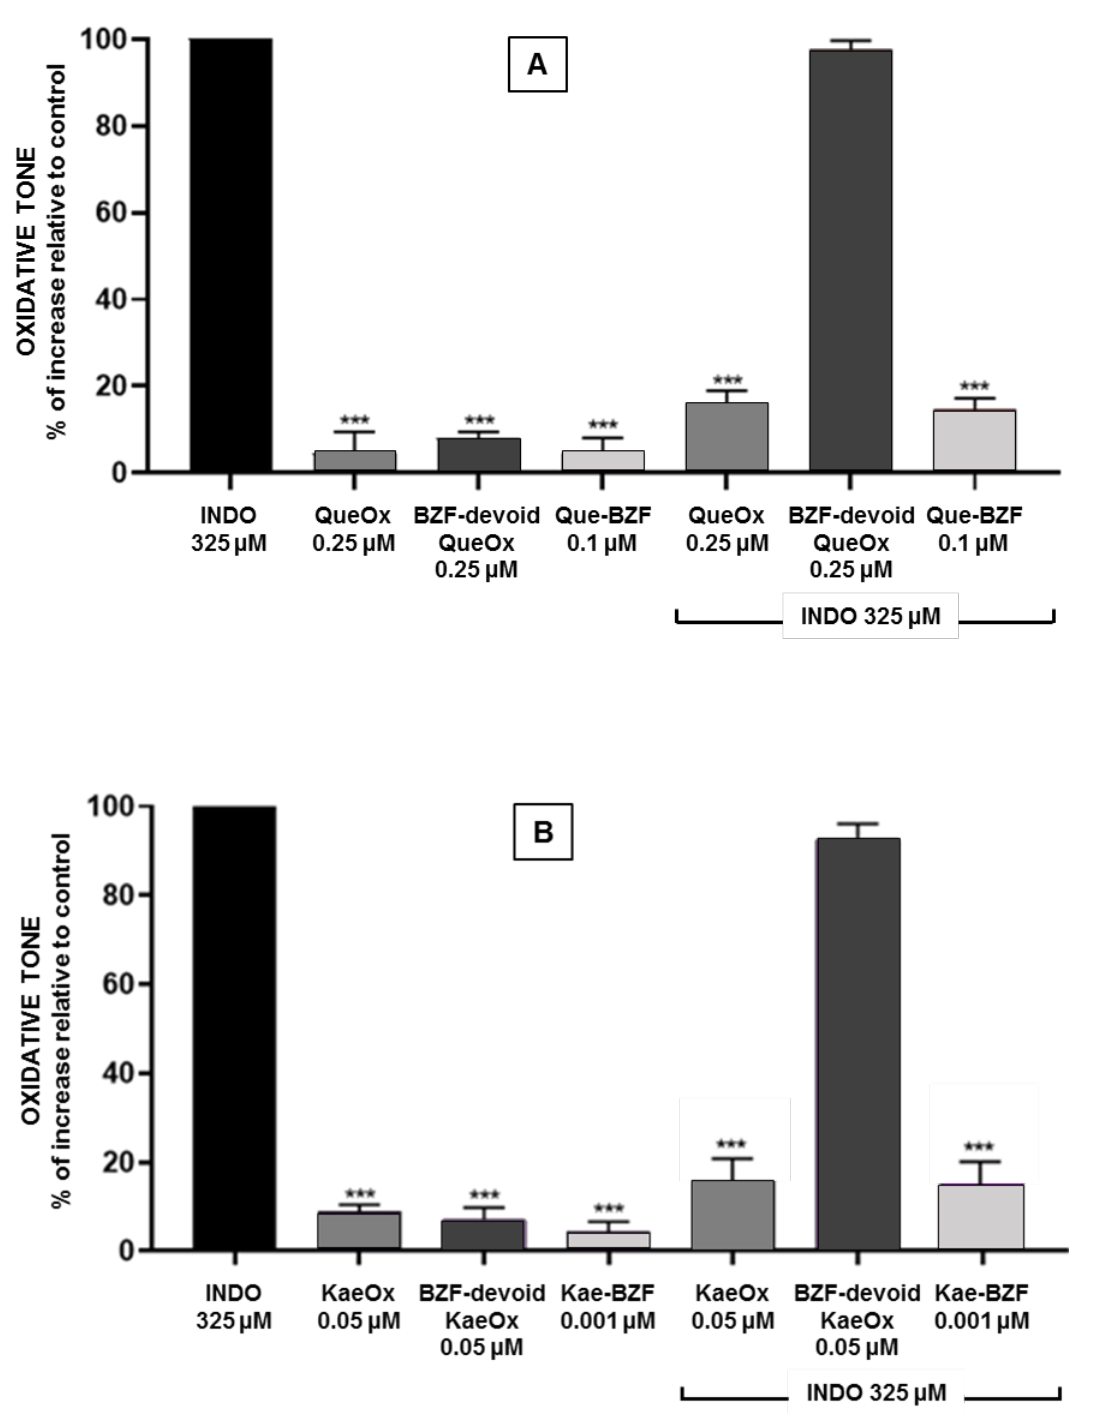
Figure 5. Comparison of the antioxidant effects of BZF-containing versus BZF-devoid flavonol oxidation mixtures. The antioxidant effects of QueOx and KaeOx are, in each case, compared with those elicited by the oxidation mixtures of ( A ) quercetin and ( B ) kaempferol, from which the BZF component was removed by chemical subtraction, and with those elicited by the BZF isolated from the former. In each case, the antioxidant effect was assessed against the increase in intracellular oxidative tone induced by indomethacin. Significant differences: *** p < 0.001 relative to indomethacin- treated cells.